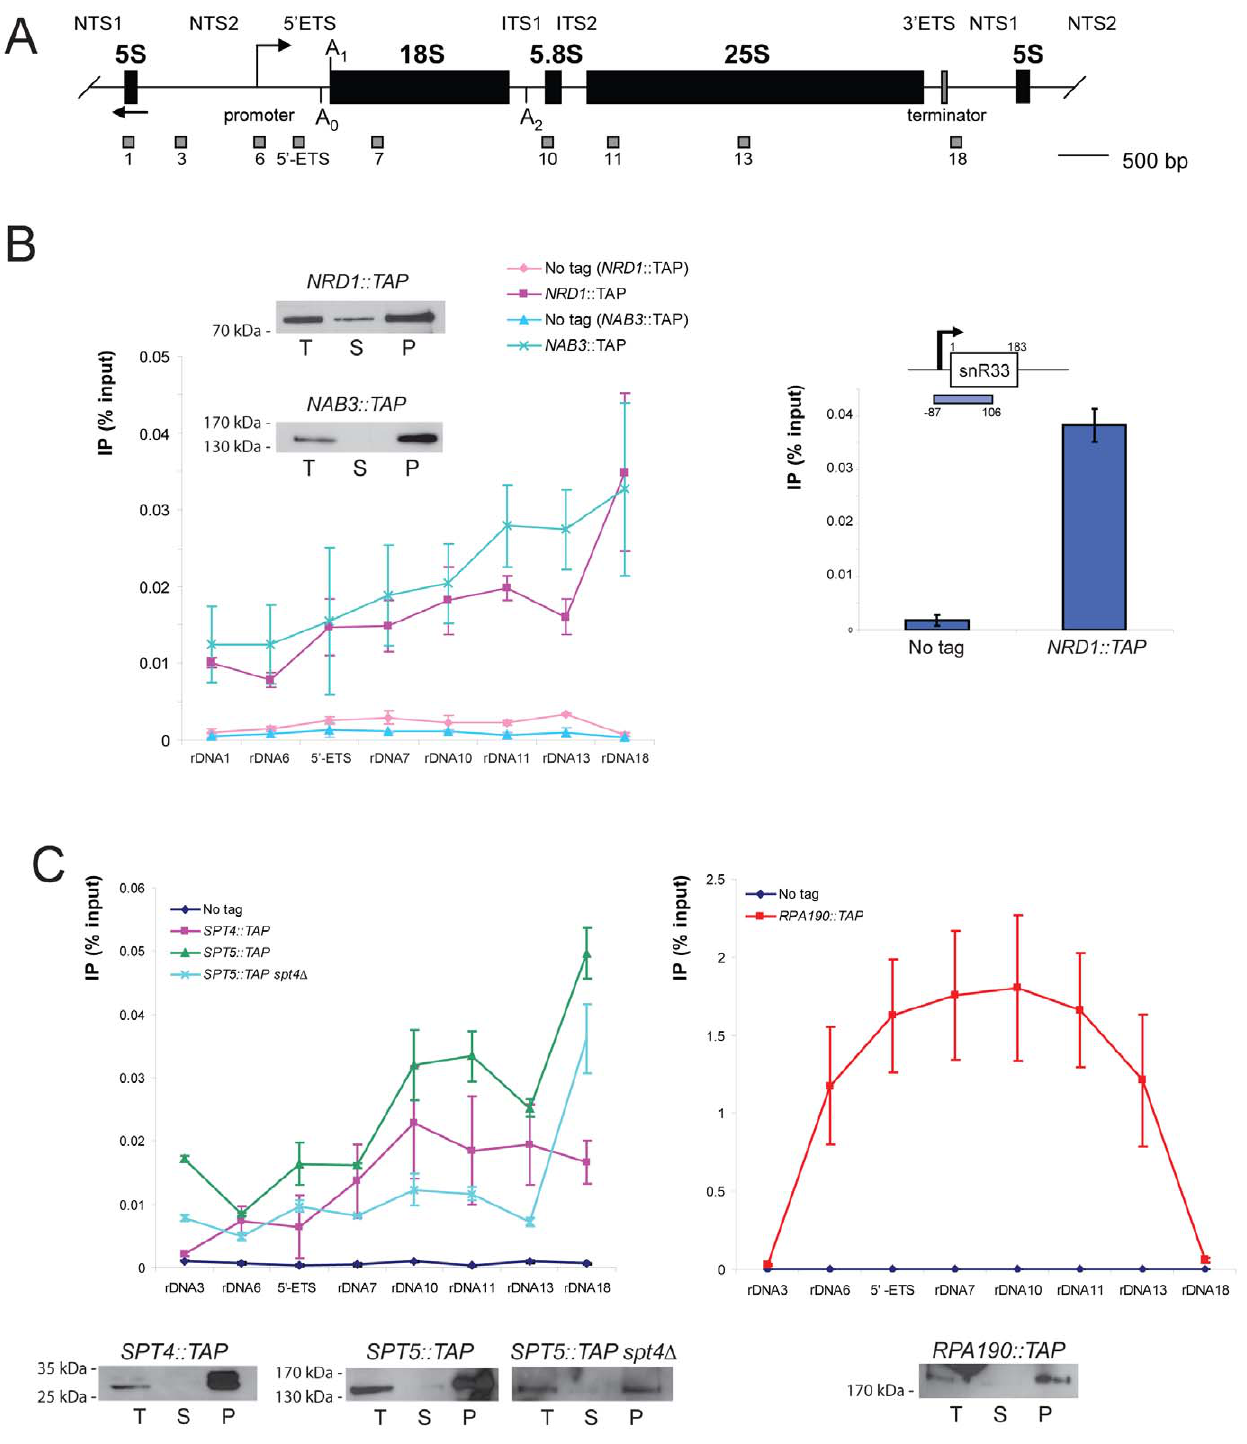
Figure 3. The Nrd1-Nab3 and Spt4-Spt5 complexes colocalize at the rDNA with a particular enrichment towards the 3 9 -end of the gene. A, Yeast rDNA unit and amplicons used in the ChIP analysis. The RNA Pol I transcript extends from the promoter to the terminator regions of the rDNA and encodes the 18S, 5.8S, and 25S rRNAs. Mature rRNAs are interspersed with external (5 9 - and 3 9 -ETS) and internal (ITS1 and ITS2) transcribed spacers. The 5S gene is transcribed by RNA Pol III in the opposite direction and is embedded in nontranscribed regions 1 and 2 (NTS1 and NTS2). Amplicons used in the ChIP analysis are indicated (1, 3, 6, 5 9 -ETS, 7, 10, 11, 13, 17, and 18). Scale bar is 500 bp. B, The Nrd1-Nab3 complex interacts with the rDNA. Chromatin extracts prepared from yeast cells expressing a functional carboxyl terminal TAP-tagged version of Nrd1 ( NRD1::TAP ) or Nab3 ( NAB3::TAP ), and an otherwise isogenic wild-type strain (No tag), grown to mid-log phase at 30 u C, were submitted to coprecipitation analysis with IgG-coated magnetic beads, and the copurifying DNA were analyzed by qPCR with oligonucleotide pairs specific to the entire stretch of the rDNA locus (see panel A). Enrichment at each position is indicated (n=3). Importantly, chromatin was extracted from independent cultures and used in independent coprecipitation analysis (biological triplicate). Inset: Western-blot analysis of protein coprecipitation